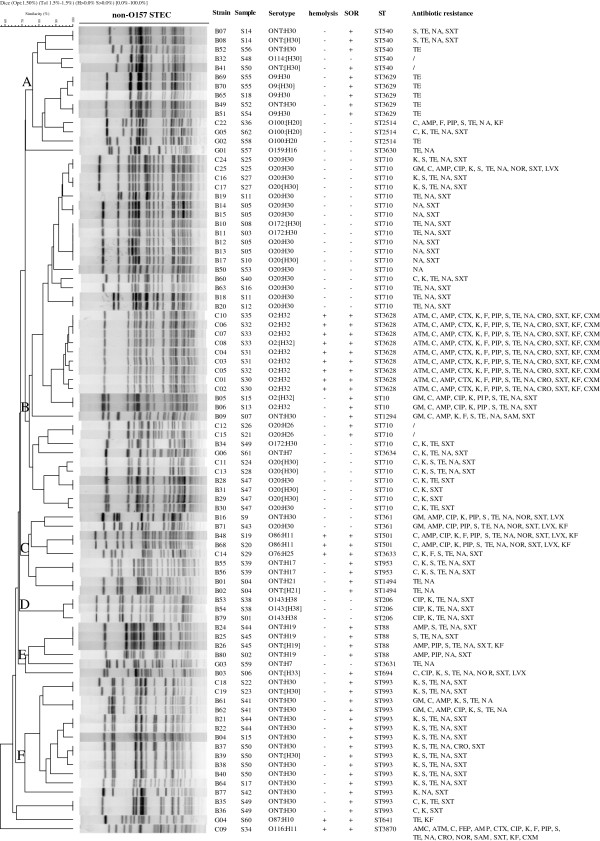
Dendrogram of PFGE profiles of 88 STEC isolates from pigs in farms and slaughter houses. The 6 PFGE clusters were marked on the node as A to F. Non-typeable with available O antisera was marked ONT and non-motile isolates were labeled with the H types in square brackets. Displayed on the right hand side are strain name, sample name, serotype, hemolysis, sorbitol fermentation (SOR), sequence type (ST) and antibiotic resistance. Abbreviations for antibiotics are: AMP, Ampicillin; PIP, Piperacillin; AMC, Amoxicillin-clavulanic acid; SAM, Ampicillin-sulbactam; FEP, Cefepime; CTX, Cefotaxime; CRO, Ceftriaxone; KF, Cephalothin; CXM, Cefuroxime; ATM, Aztreonam; IPM, Imipenem; MEM, Meropenem; GM, Gentamicin; K, Kanamycin; S, Streptomycin; TE, Tetracycline; CIP, Ciprofloxacin; NOR, Norfloxacin; LVX, Levofloxacin; NA, Nalidixic acid; SXT, Trimethoprim-sulfamethoxazole; C, Chloramphenicol; F, Nitrofurantoin. Place of isolates were contained in the first letter of strain names: B means Beijing city, C means Chongqing city and G means Guizhou province.